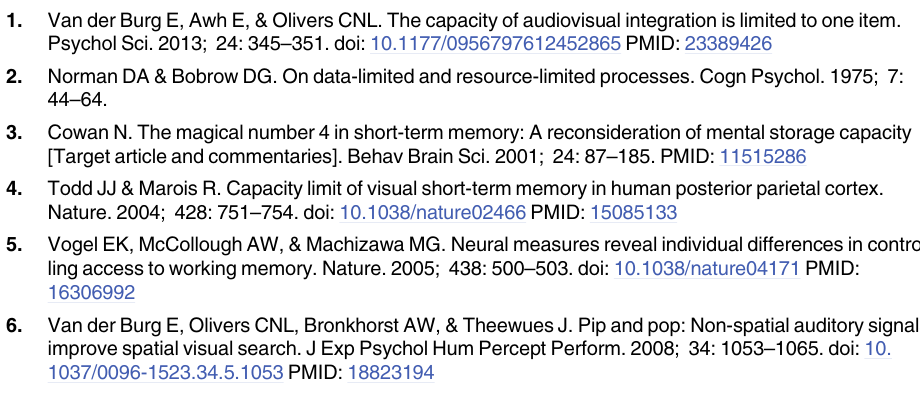
S1 Table. Average number of epochs entered into encoding and retrieval analyses as a function of SOA (200, 700) and number of locations changed (1, 2, 3,